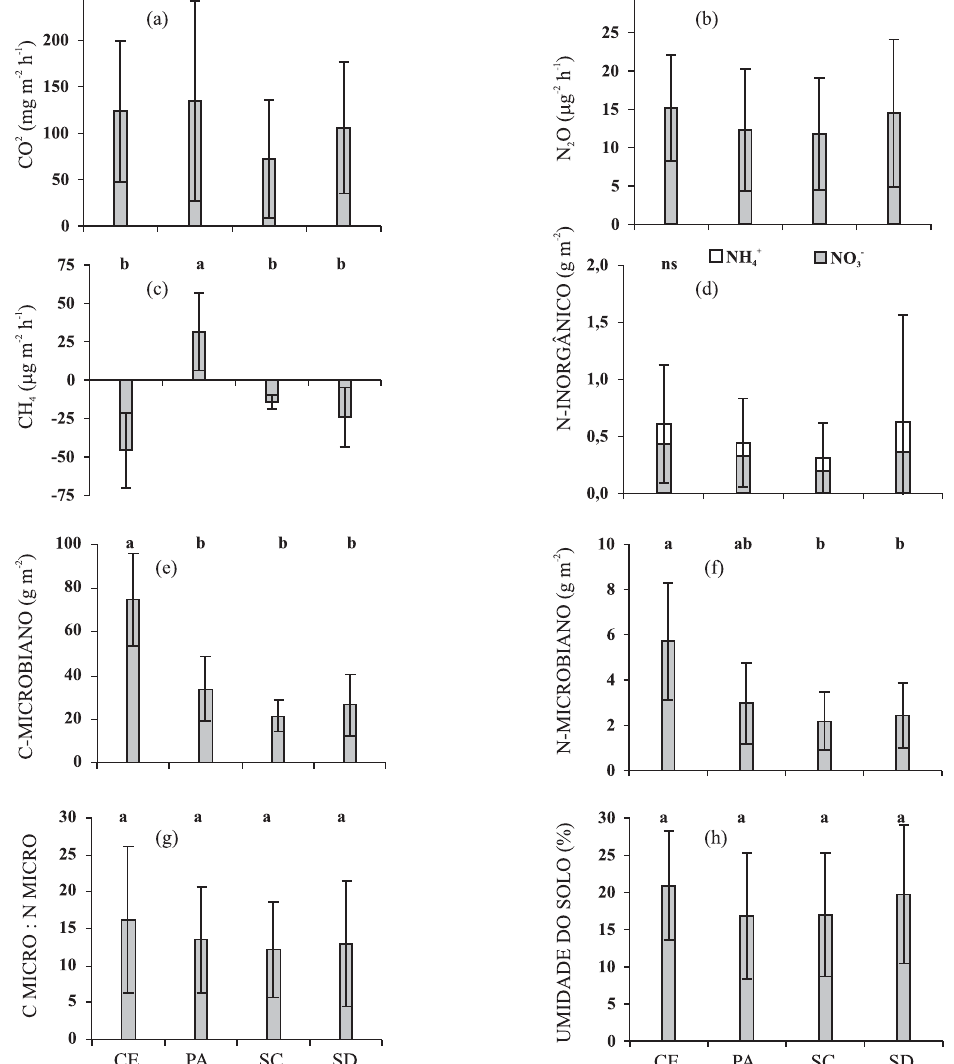
; (b) emissão de N O; (c) fluxo de CH ; d) N-inorgânico 2 2 4